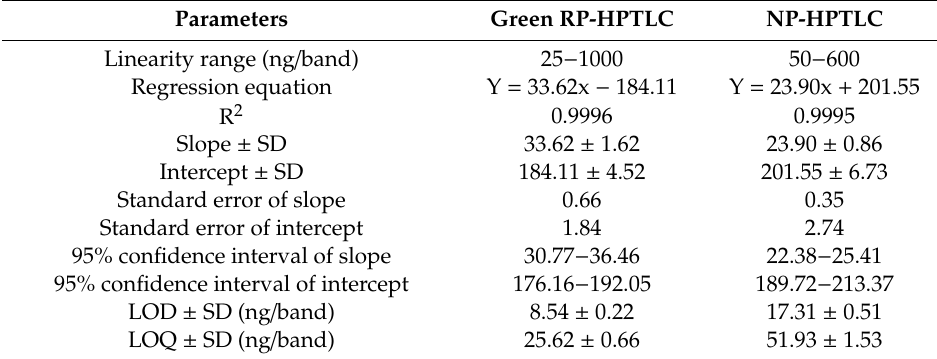
Table 2. Linear regression data for the calibration curve of DLFX for green RP-HPTLC and NP-HPTLC methods ( n = 6).